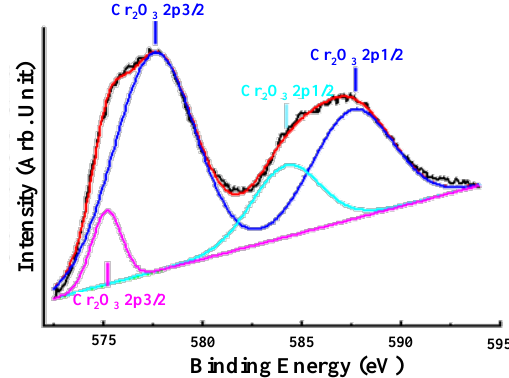
Figure 3. The XPS spectrum of O 1s of the 316L BSS specimen with anodization at 5 V for 5 min.